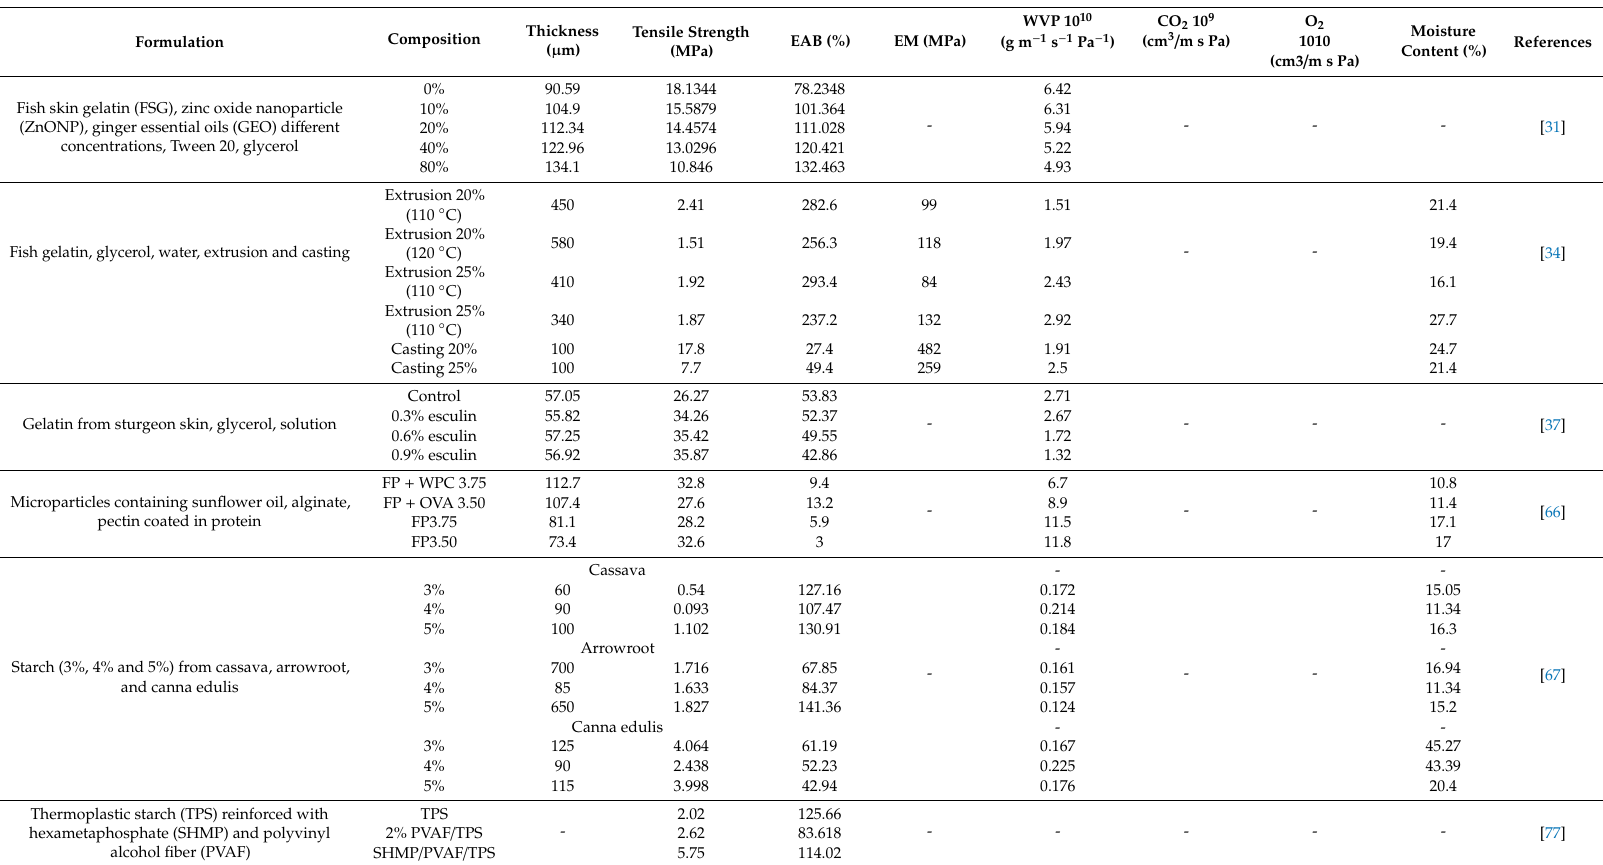
Table 2. Examples of formulations where mechanical and barrier parameters are changing as a function of composition.